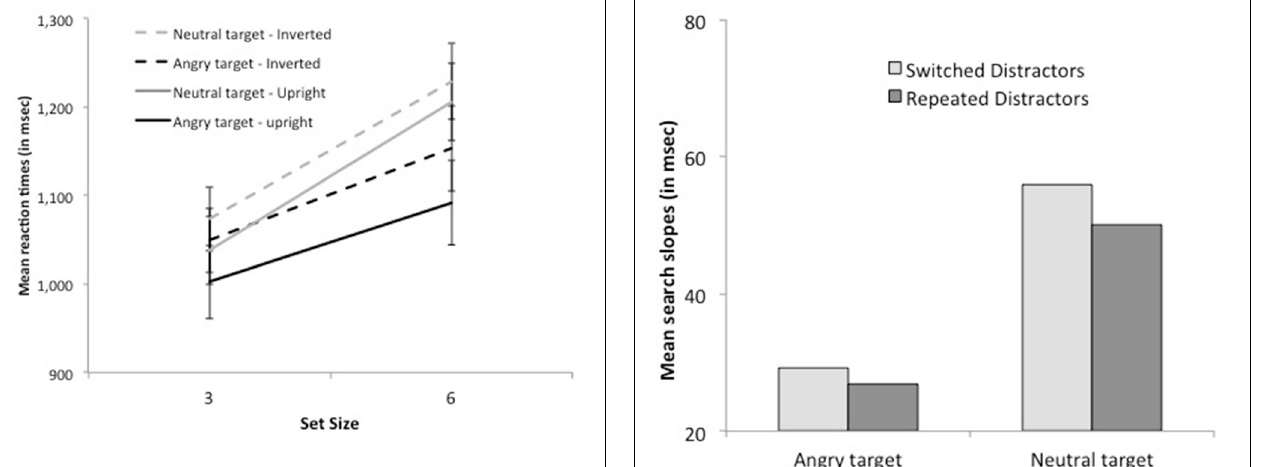
FIGURE 2 | Mean reaction times on target-present trials for set size 3 and 6 as a function of target emotion (angry or neutral) and face orientation (upright or inverted) in Experiment 1. FIGURE 3 | Mean search slopes (mean additional reaction time for